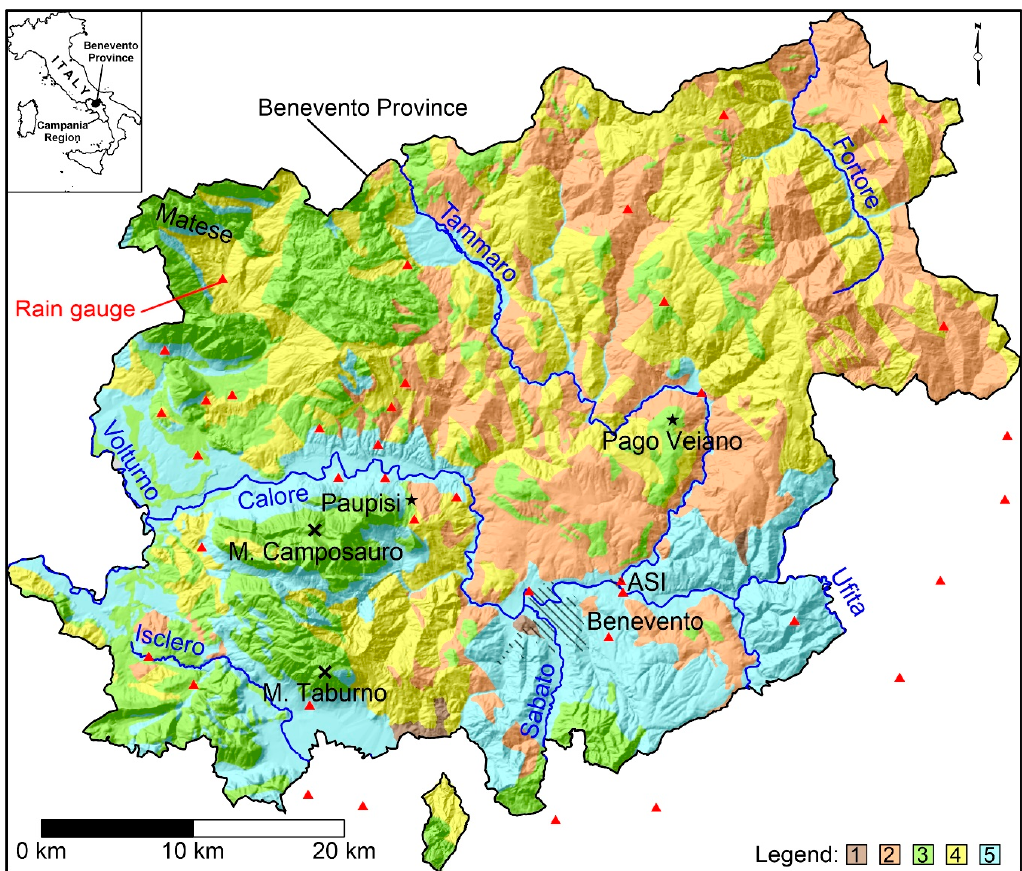
Figure 1. Outcropping of litho-technical sequences in the Benevento province (modified from [18]). Legend: (1) Predominantly pelitic sequences (from low to medium degrees of tectonization); (2) predominantly pelitic sequences (high degree of tectonization); (3) rock sequences (from low to medium degrees of tectonization); (4) rock and complex successions (high degree of tectonization); (5) coarse clastic and / or inhomogeneously lithified sequences. Rain gauges considered for our analysis are reported using red symbols. The industrial area of Benevento (ASI) is labeled.